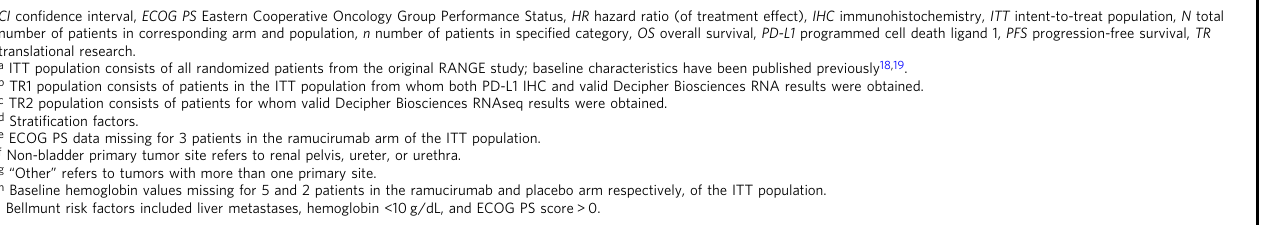
in fl amed, activated CD4, activated CD8, memory CD8, and mean immune signatures showing OS treatment effect (HRs ranging from Supplementary Table 1. Interactions between treatment and immune signature scores (>median vs. ≤ median) were signi fi cant for the T-effector ( p = 0.036) and activated CD4 T-cell ( p = 0.022) (Fig. 2c). However, there was no clear association between high angiogenesis signature scores and ramucirumab bene fi t (Fig. 2c). Additionally, to explore the association between ramucirumab bene fi t and angiogenesis and immune mean signature score in a continuous manner, the STEPP method was utilized (Supplemen- tary Fig. 1b, c). The 95% CI of the HR was consistently below 1 when the subpopulation median immune signature score went above 0.36 con fi rming the fi nding in dichotomized analysis that high immune signature scores provided OS ramucirumab bene fi t. However, no clear trend was observed for the angiogenesis mean signature score.